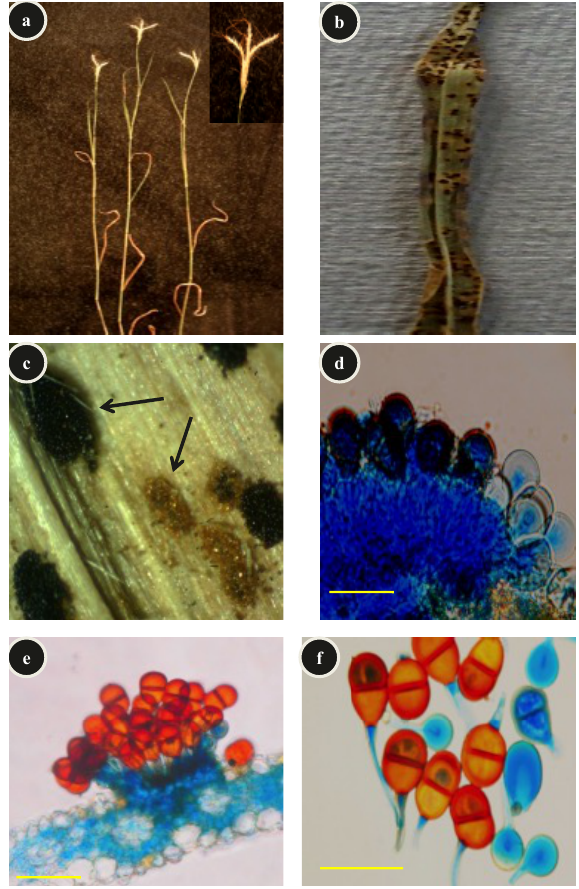
Image 1. Puccinia duthiae : a - habitat of host; b - symptom; Fig.1 Puccinia duthiae : a-Habit of host , b-Symptom , c- Arrow showes enlarged c - arrow shows enlarged uredenia and telia; d - transverse section uredenia and telia, d–Transverse section of leaf showing urediniospore and of leaf showing urediniospore and paraphyses (bar = 50µm); paraphyses (bar = 50 µm), e-Transverse section of leaf showing teliospores ( bar e - transverse section of leaf showing teliospores (bar = 50µm); = 50 µm), f- teliospore and paraphyses ( bar = 40 µm) f - teliospore and paraphyses (bar =